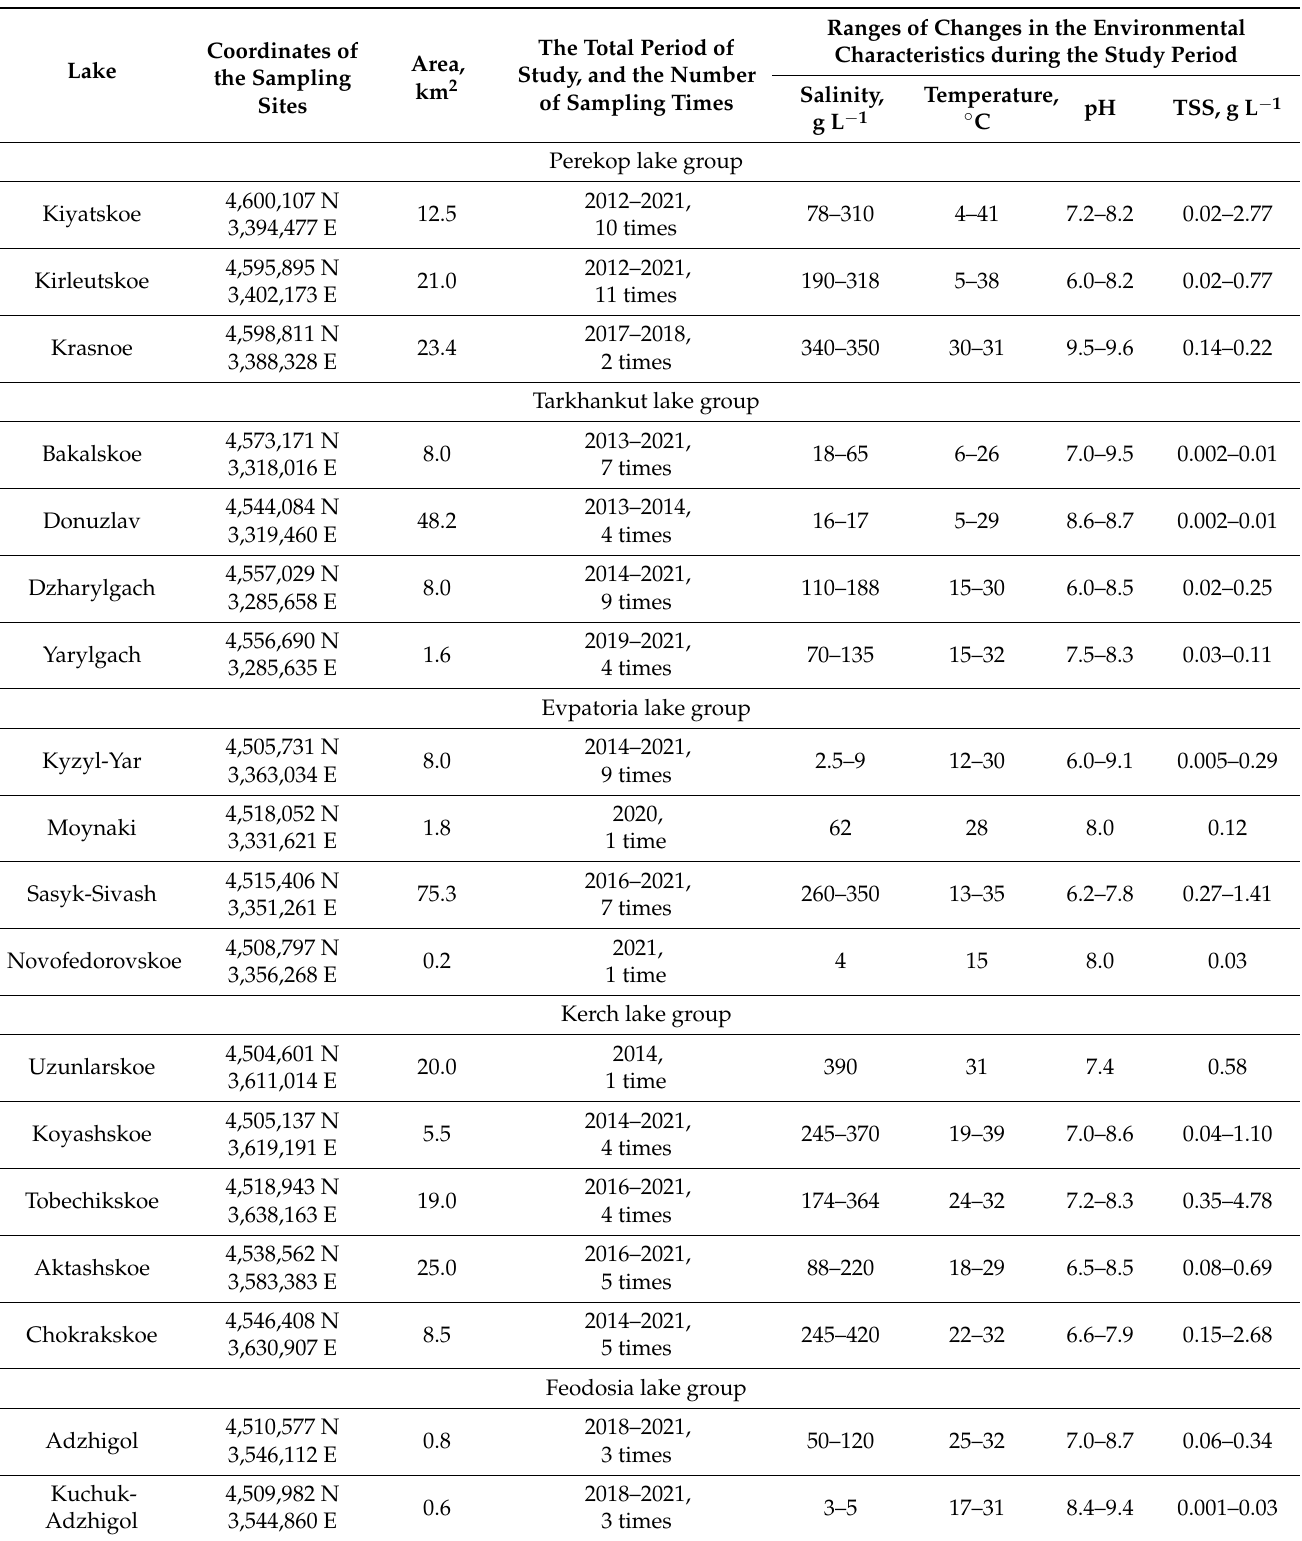
Table 1. The studied Crimean saline lakes and their